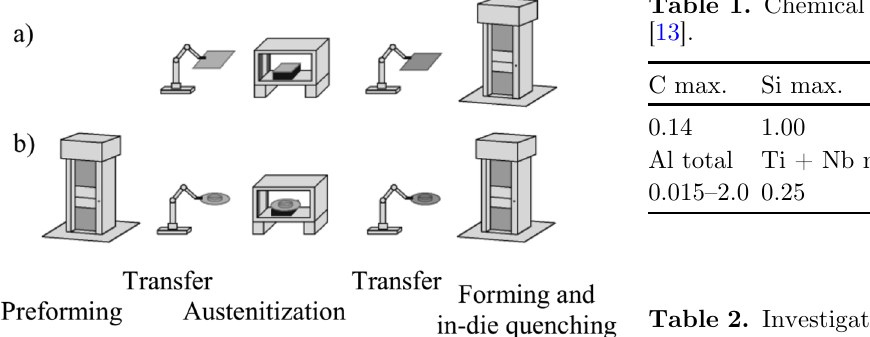
Table 1. Chemical composition of CP-W ® 800 in wt.%